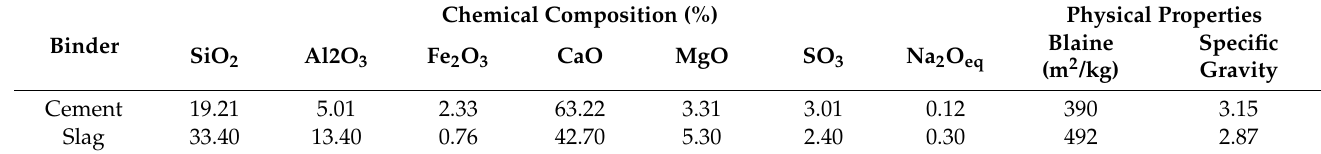
Table 2. Properties of fibers.